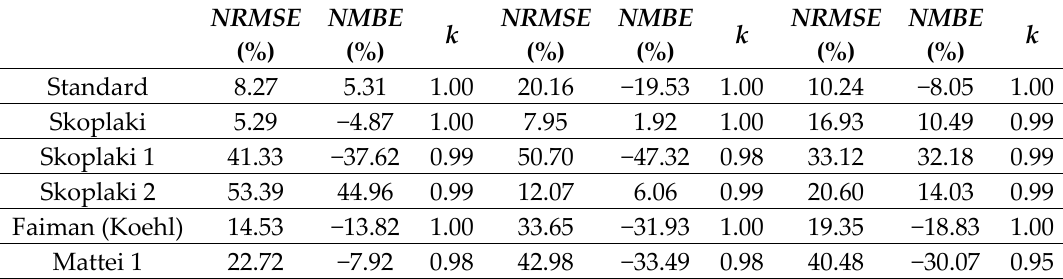
Table 1. NRMSE , NMBE values and Pearson’s correlation coefficient for monthly temperatures mean values of PV1, PV2 and PV2b installations modules calculated with the use of mathematical models for